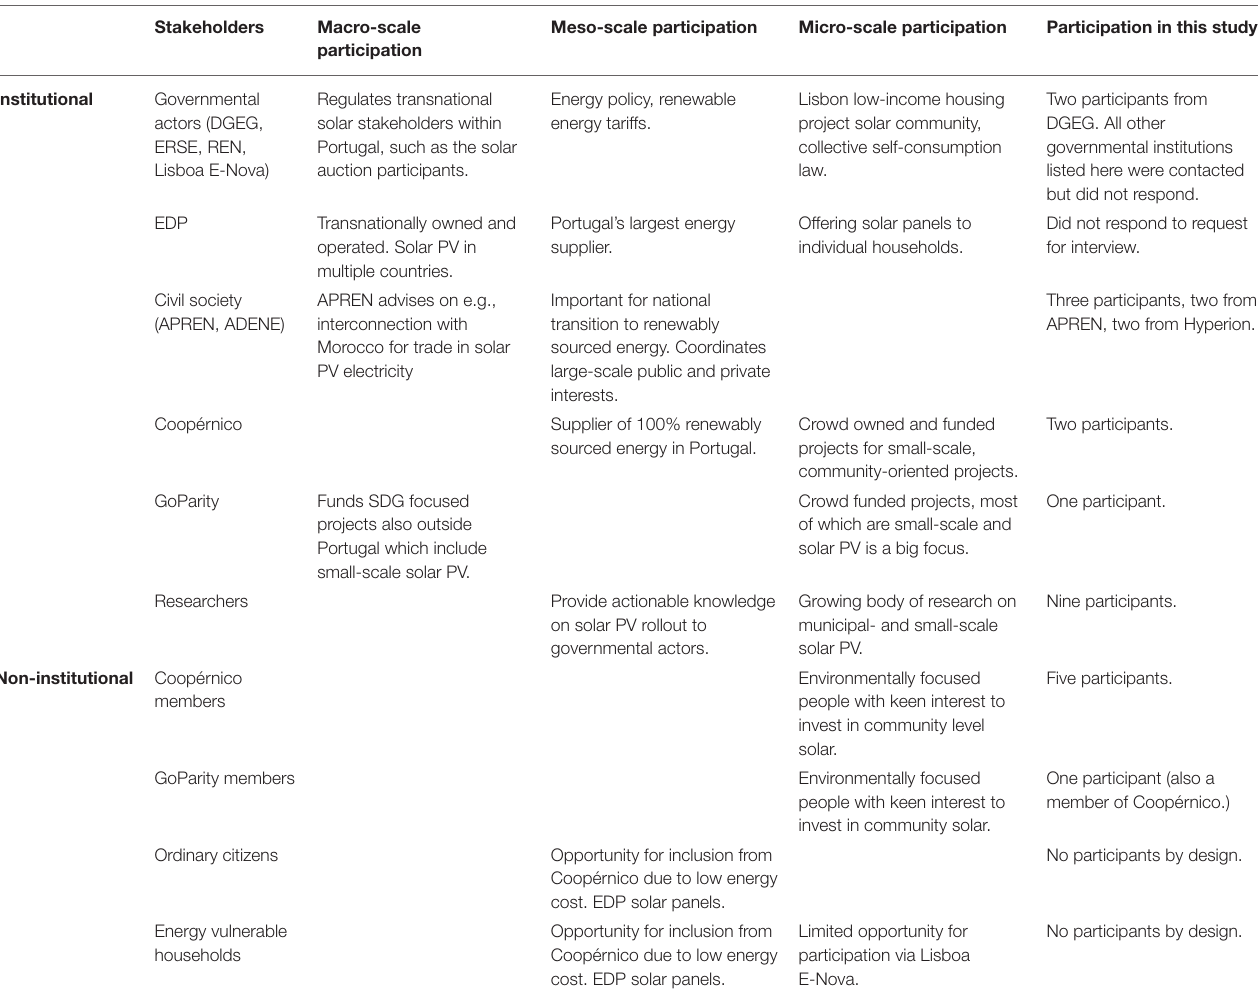
TABLE 1 | Scalar participation in solar PV by various institutions and actors in